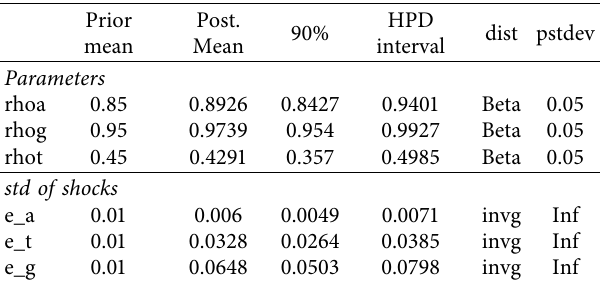
Table 2: Bayesian estimation